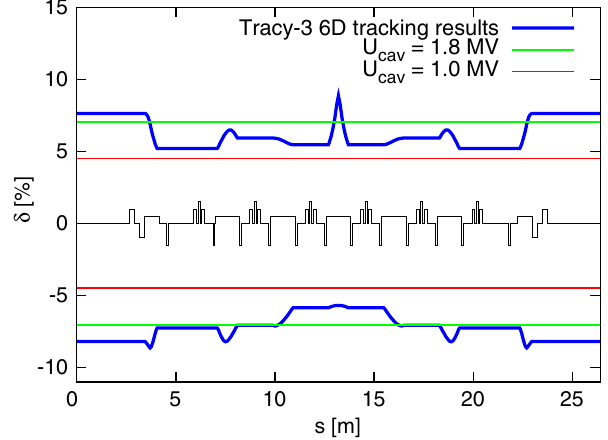
FIG. 3. Lattice MA for one achromat of the MAX IV 3 GeV storage ring. The solid blue line shows lattice MA from 6D tracking with T RACY -3 using actual vacuum chamber apertures. For comparison, the bare lattice rf acceptance is shown as well: cavities at maximum voltage 1.8 MV (7.1% rf acceptance) and at 1.0 MV (4.5% rf acceptance). The magnetic lattice is indicated at the center. (above ≈ 1000 pm rad), one can recognize the entirely different behavior of ultralow-emittance rings (below ≈ 500 pm rad) where a sharp increase of Touschek lifetime occurs when the emittance is lowered. The MAX IV 3 GeV storage ring is clearly operated in this regime where Touschek lifetime can be expected to improve as IDs are added.